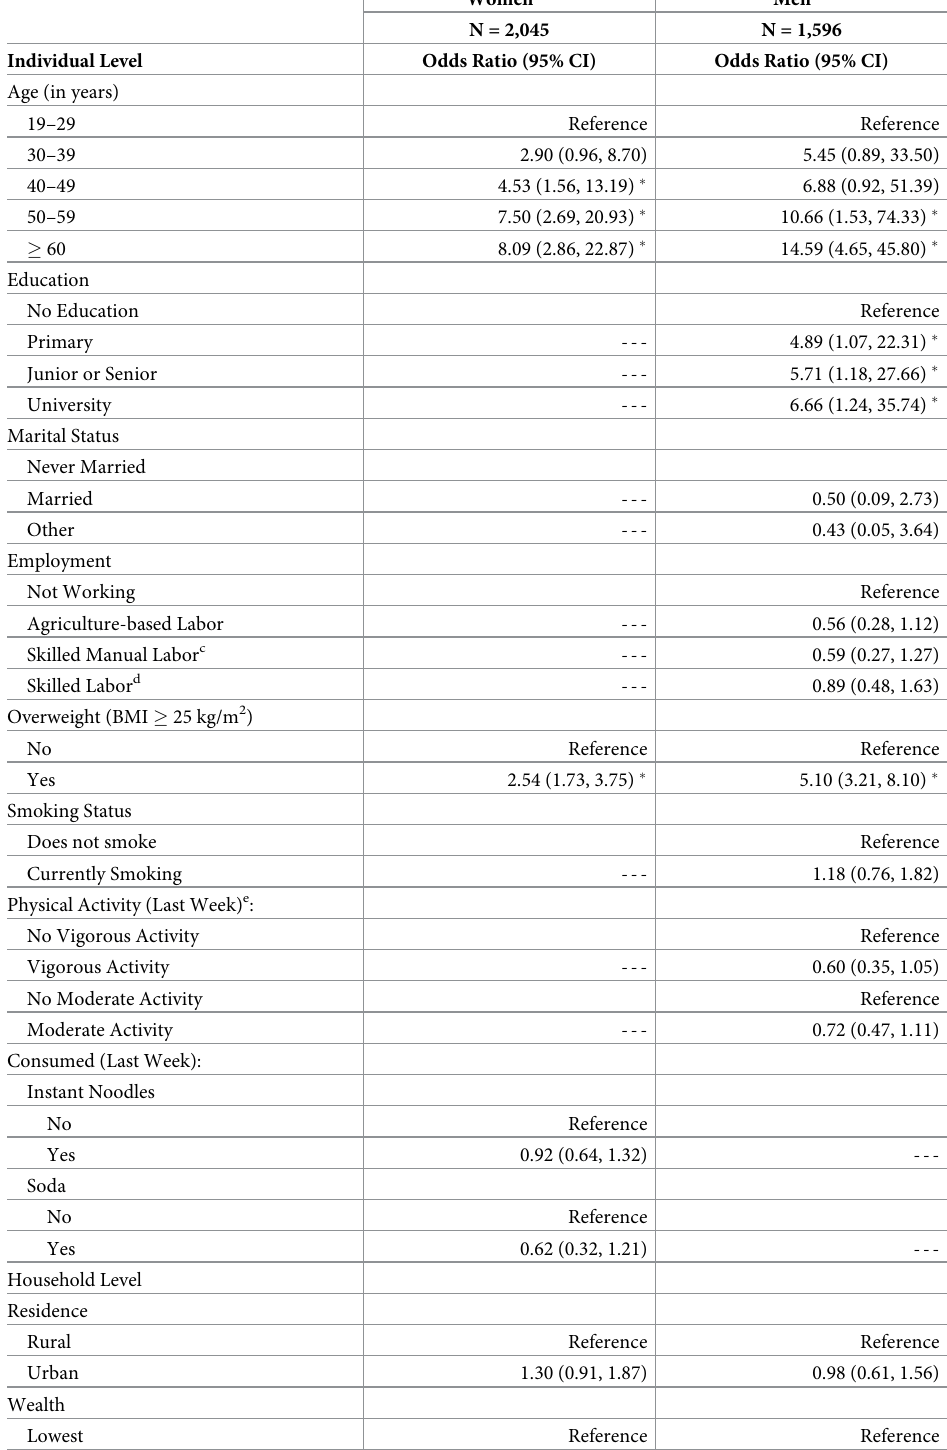
Table 5. Multivariable Logistic Regression Testing the association between selected characteristics and Type 2 diabetes among adults in Indonesia,